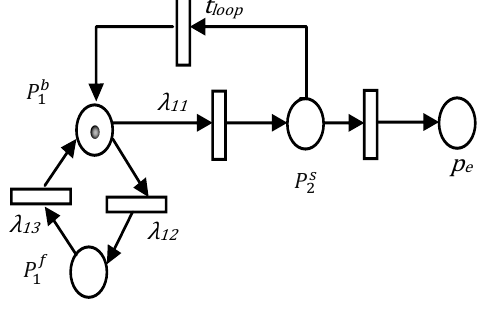
Figure 4. Loop component model based on